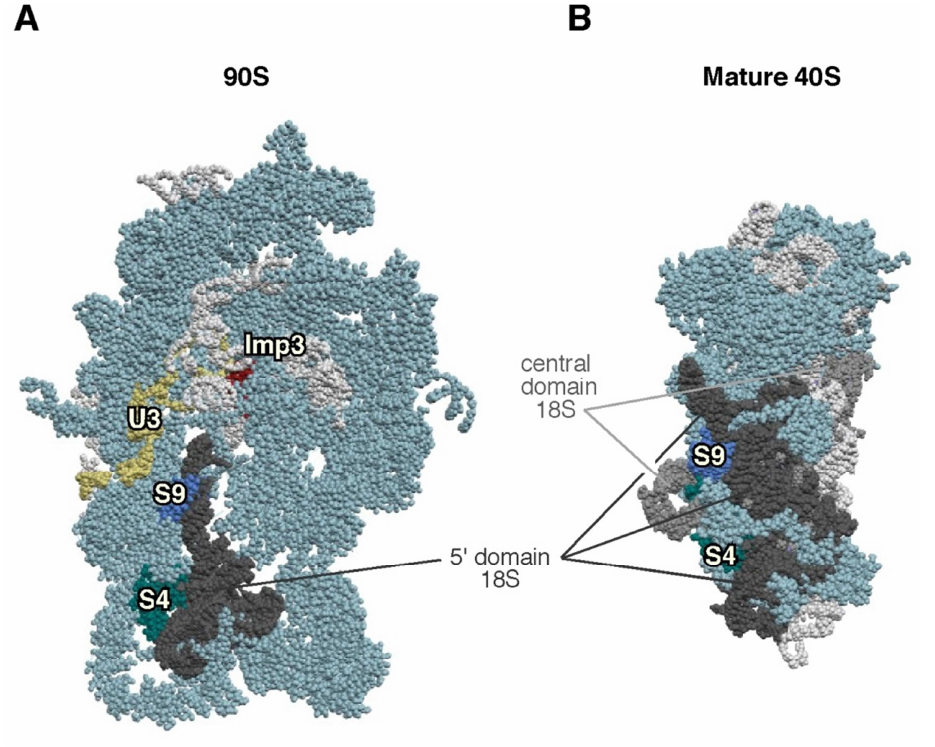
Figure 4: Imp3 is not the placeholder factor for the assembly of S9 r-protein. (A) Position of Imp3 (red) and S9 (medium blue) in the 90S pre- ribosomal particle,